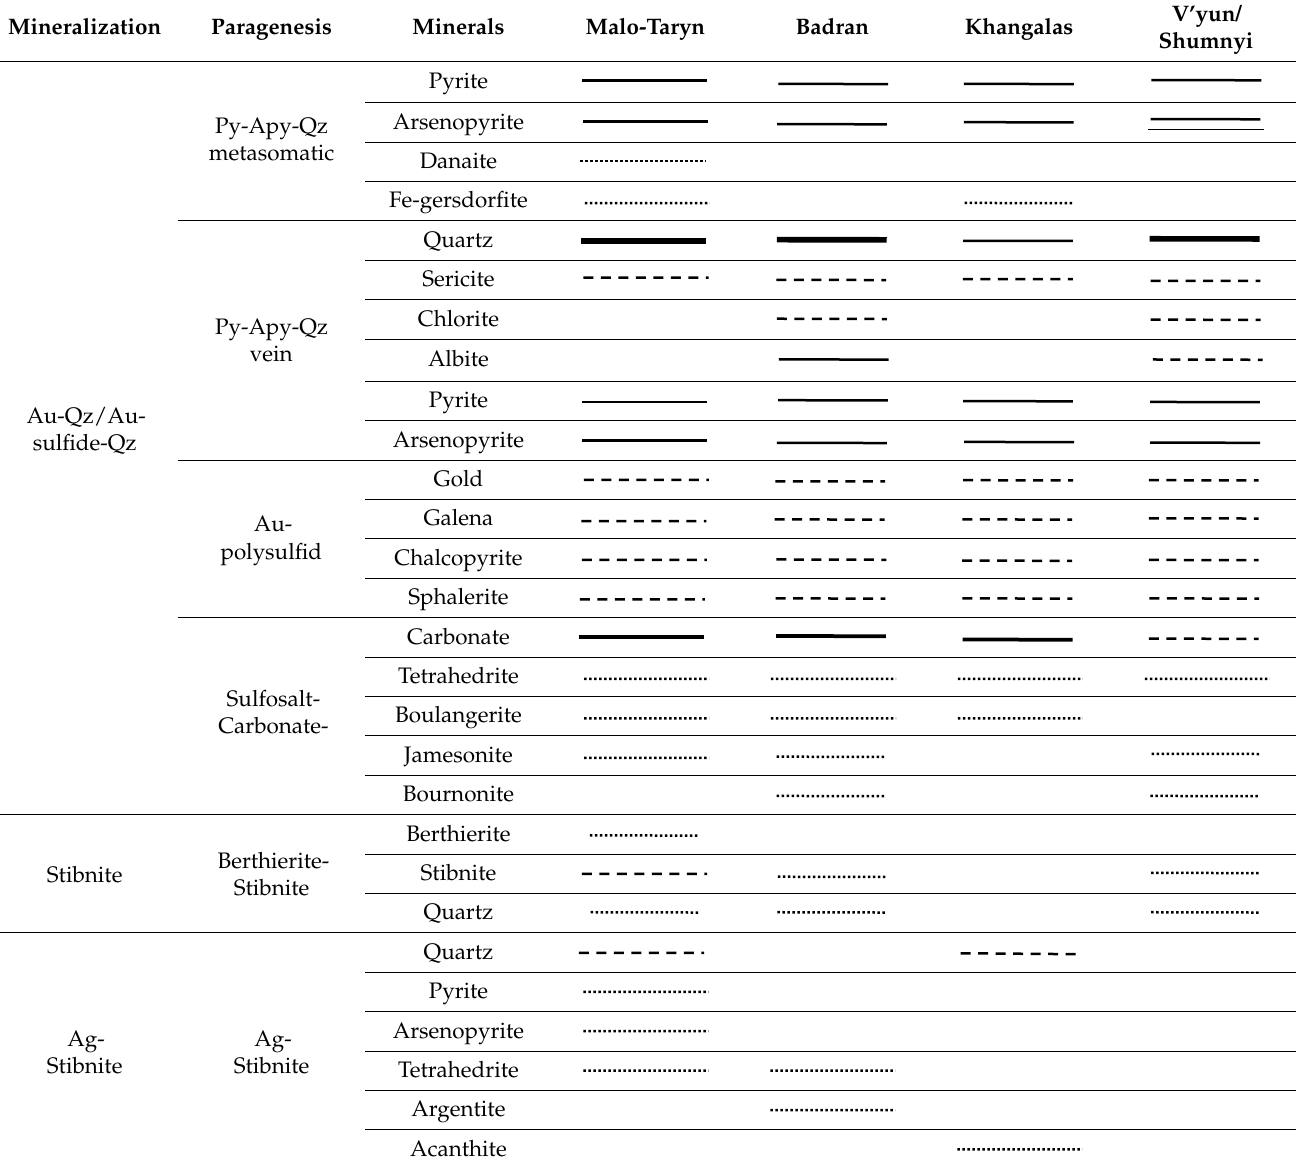
Table 2. Mineral composition of ores and mineralization types of the studied OGDs, central YKMB.